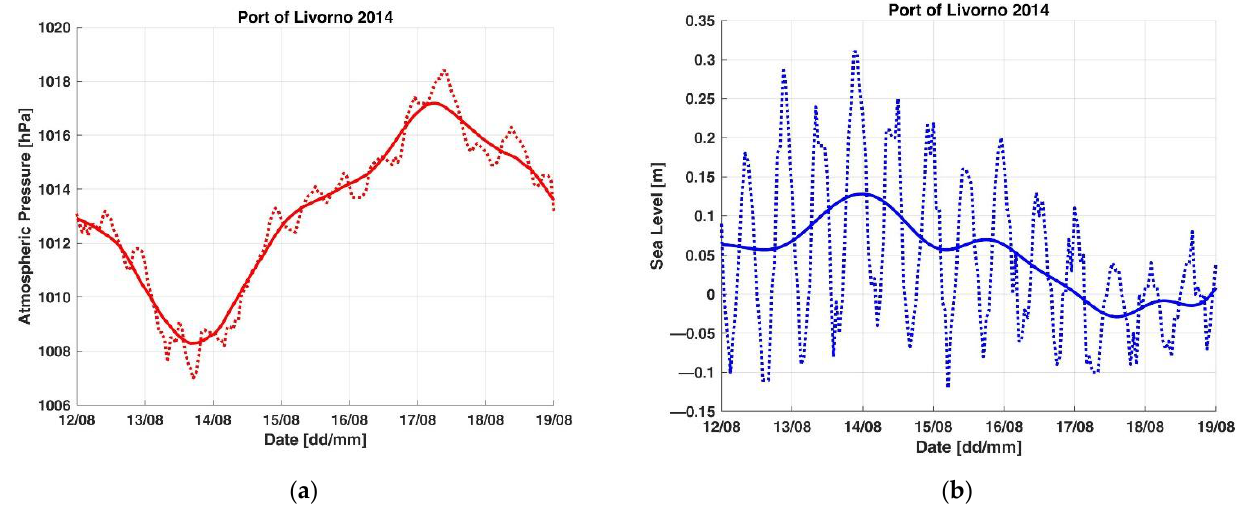
Figure A4. Low-frequency components of meteo-mareographic parameters acquired by ISPRA’s monitoring station in the port of Livorno from 12 to 19 August 2014 ( a ) atmospheric pressure; ( b ) sea level.